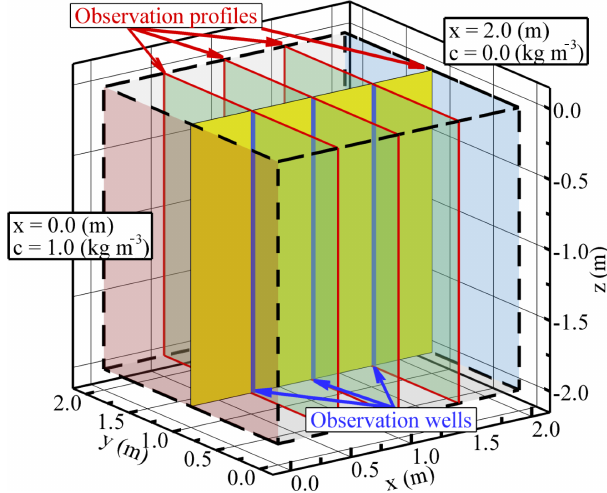
Figure 5. Conceptual model and the specified well and profile loca- tions for the calculations of the flow and transport